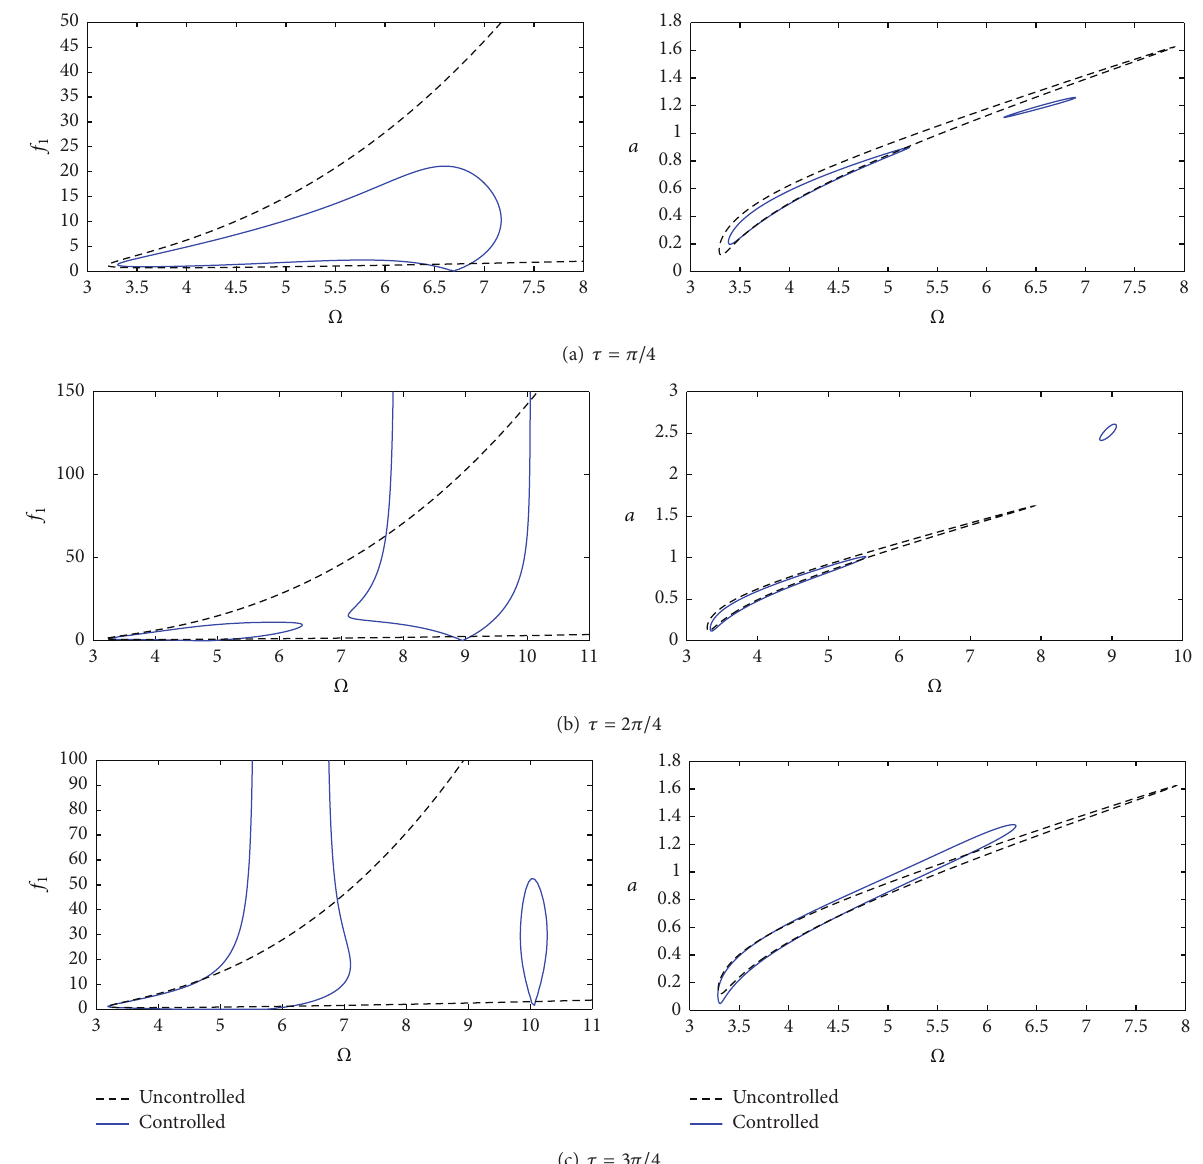
Figure 14: Existence regions and amplitude-frequency relationships of the 1/3 subharmonic resonance for the controlled system with different ̂𝜆 = 0.4 , and 𝑓 1 = 2 time delay 𝜏 ( 𝜁 1 = 0.025 , 𝜁 3 = 0.025 , 𝑘 = 1 ,